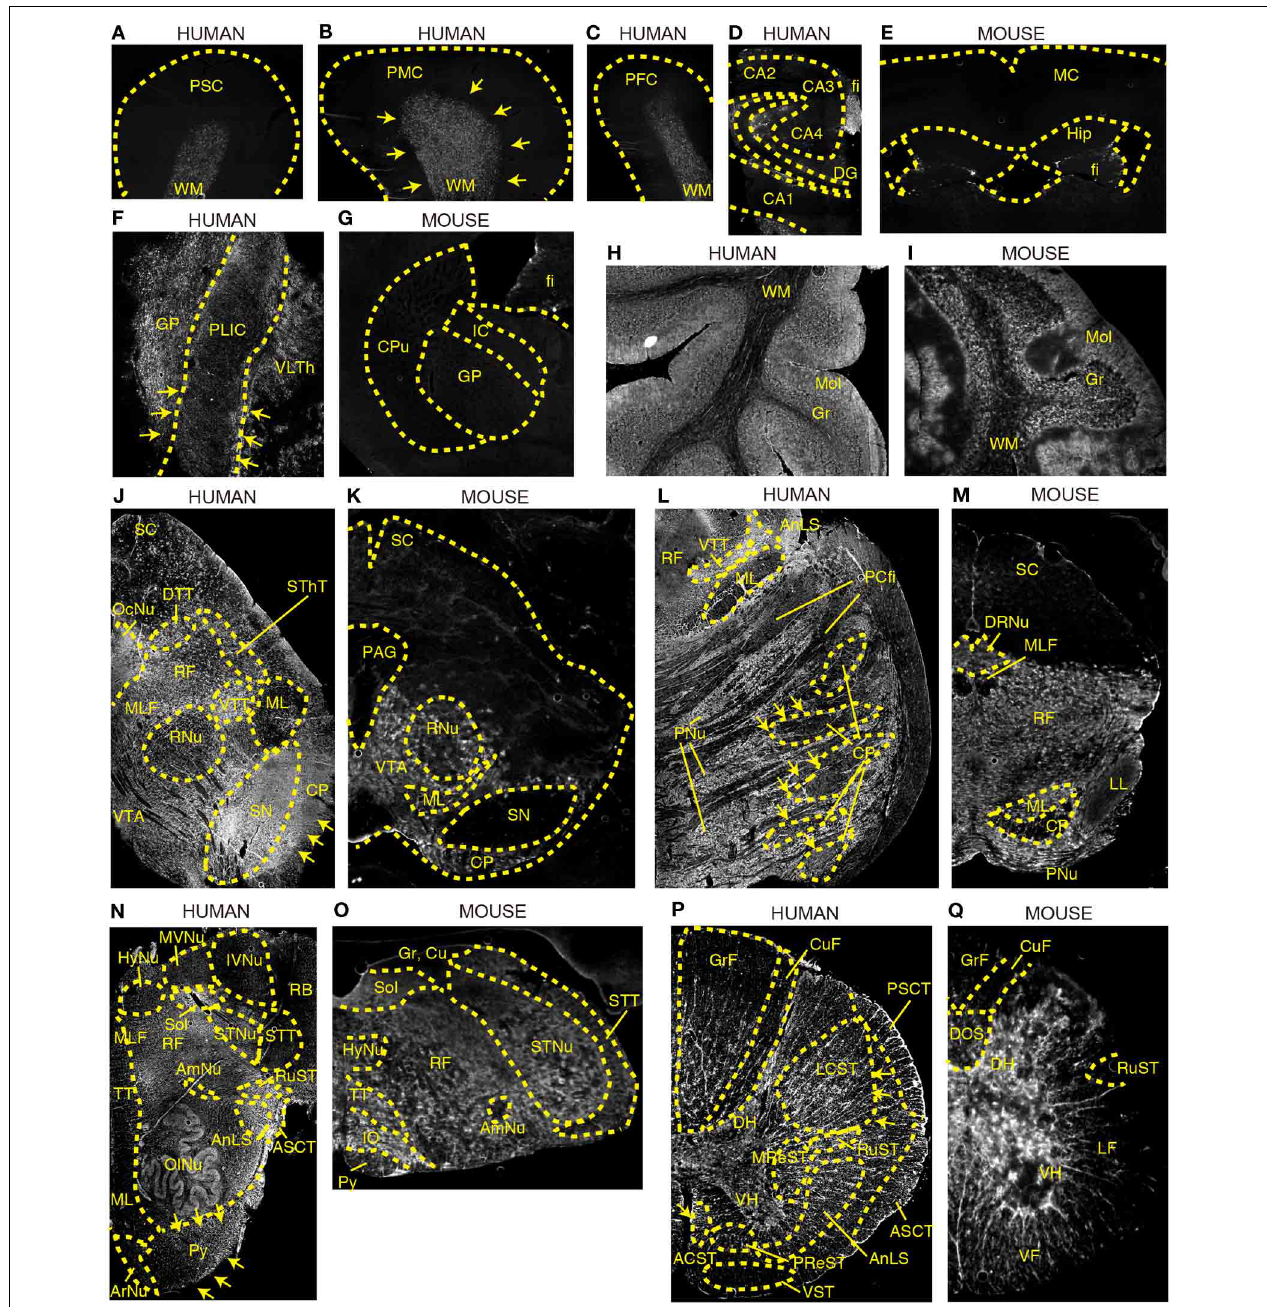
FIGURE 2 | DAO enzyme histochemistry in human and mouse CNS. DAO activity was visualized using D-proline as a substrate in various regions of brain. Shown are (A–C) human cerebral cortex, (D) human hippocampus, (E) mouse forebrain including cerebral cortex and hippocampus (a coronal section), (F) posterior limb of human internal capsule (a horizontal section), (G) mouse striatum and internal capsule (a coronal section), (H) posterior lobe in human cerebellar hemisphere, (I) mouse cerebellar hemisphere, (J)